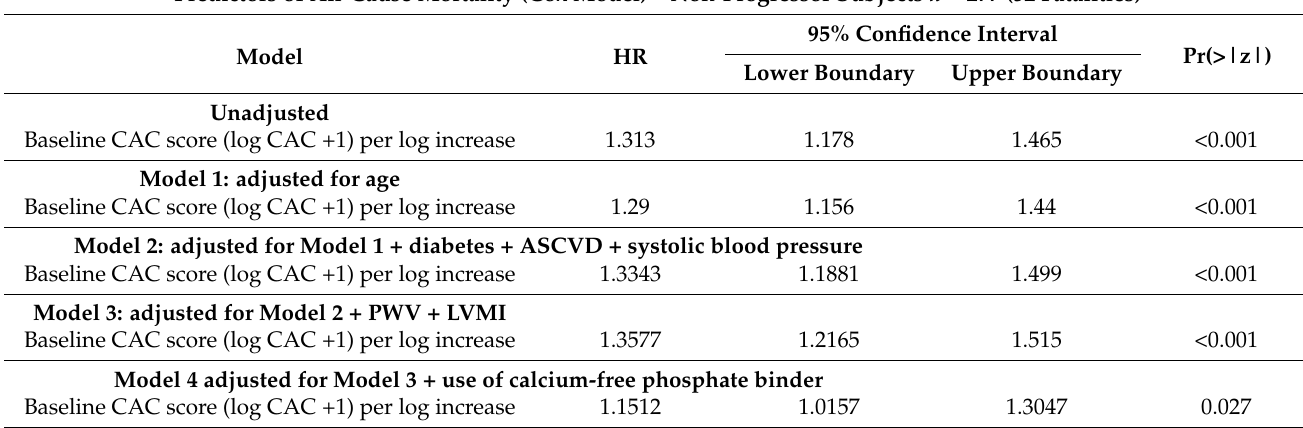
Table 5. Predictors of all-cause mortality among individuals without evidence of coronary artery calcification (CAC) progression.